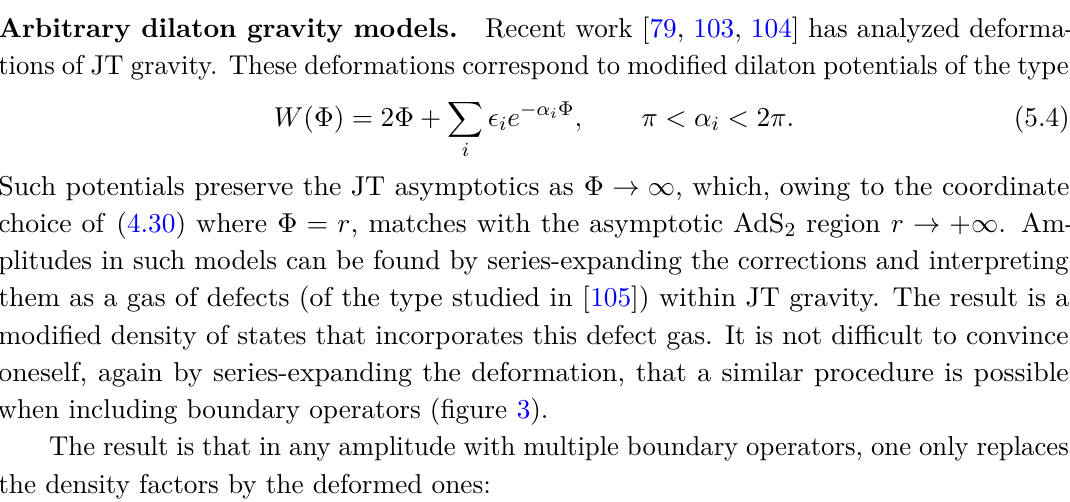
Figure 3 . Deformed JT gravity disk amplitude with two boundary operators, interpretable as undeformed JT gravity with a gas of defects localized in the interior of the disk (blue blob).